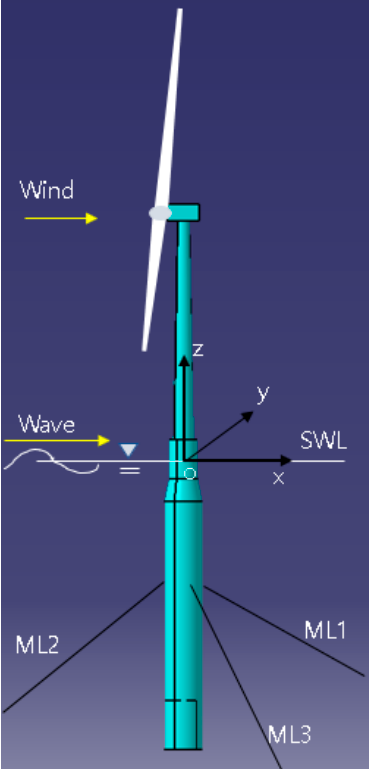
Figure 2. Overview of spar-type FOWT and global coordinate system. Note: ML = Mooring line.